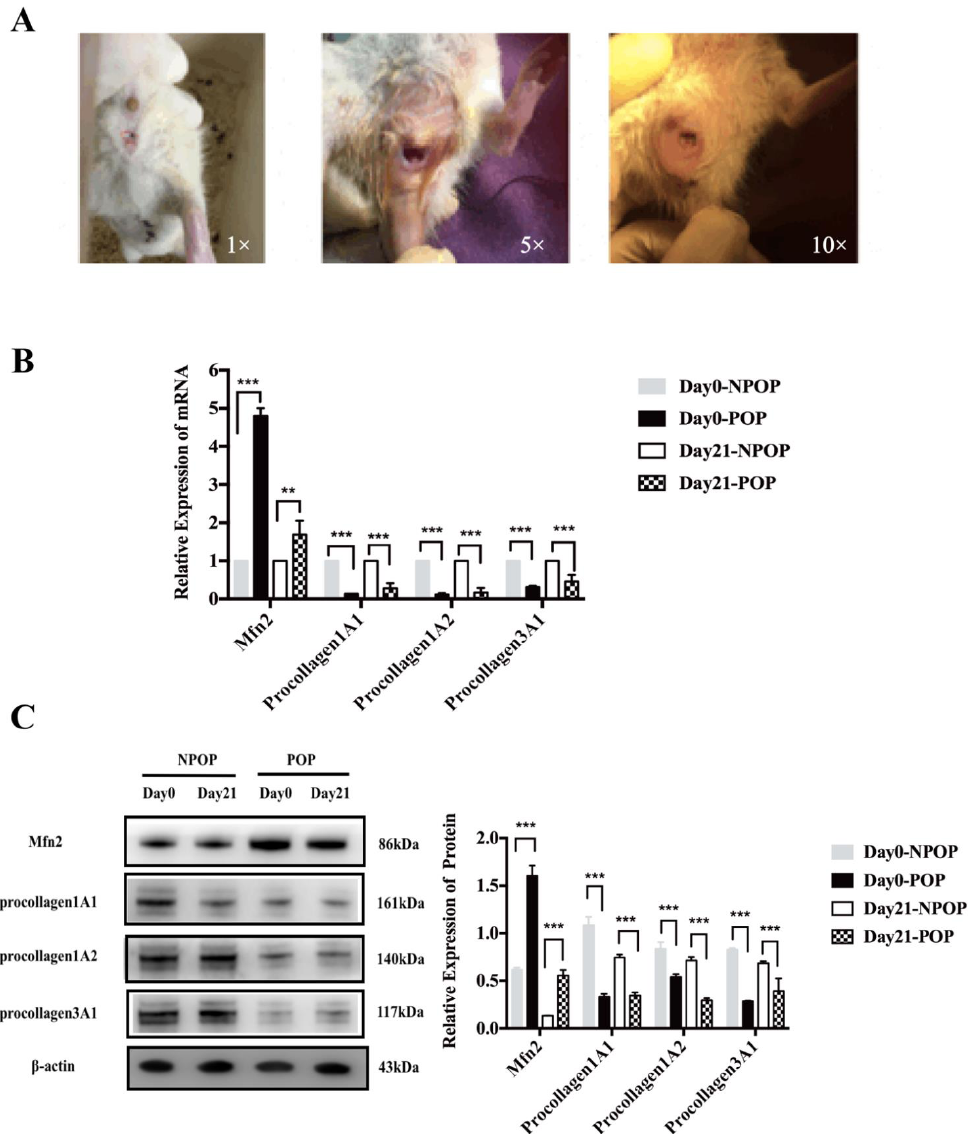
Figure 1. Establishment of the POP rat model. ( A ) From left to right, after one, five, and 10 stretching cycles. ( B ) After the model was established, the uterosacral ligaments in rats in the POP and NPOP groups were collected on days 0 and 21 for qRT-PCR detection. ( C ) After the model was established, the uterosacral ligaments in the rats in the POP and NPOP groups were collected on days 0 and 21 for Western blot detection. ** p < 0.01, *** p < 0.001.